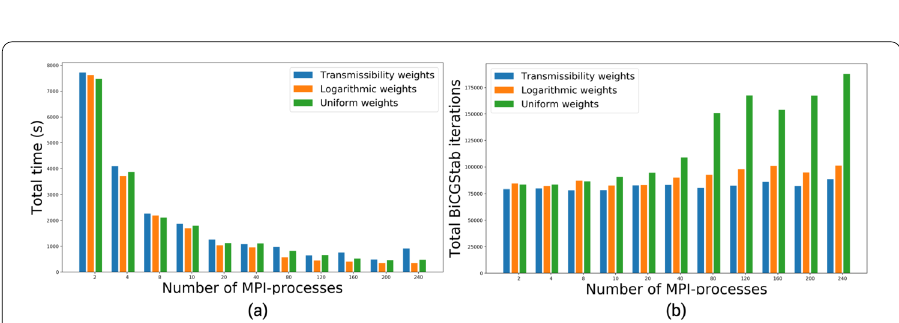
Figure 12 Overall time usage of the parallel Flow reservoir simulator when applied to the Norne benchmark case, measured on the Abel cluster. Beyond 16 MPI-processes, the simulations were conducted on multiple computational nodes